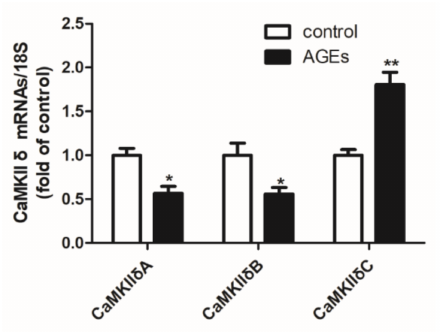
Figure 3. AGEs aggravated the disorder of CaMKII δ alternative splicing in cardiomyocytes. Car- diomyocytes were stimulated with AGEs (200 µ g/mL) for 24 h. The mRNA expression of CaMKII δ A, CaMKII δ B, and CaMKII δ C was detected by quantitative real-time PCR in cardiomyocytes. 18S was used as a loading control. Plots represent the mean ± SEM; n = 6. Statistical significance: * p < 0.05, ** p < 0.01 compared with control.